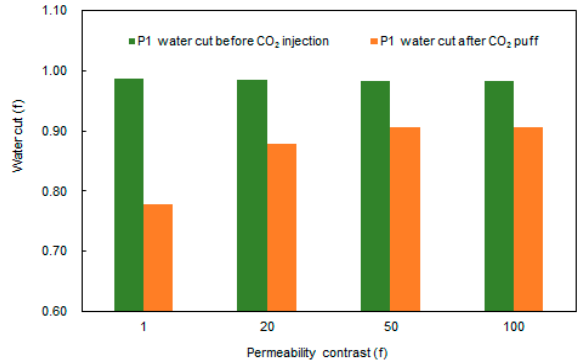
Figure 24. P1 well water cut with different permeability contrasts.